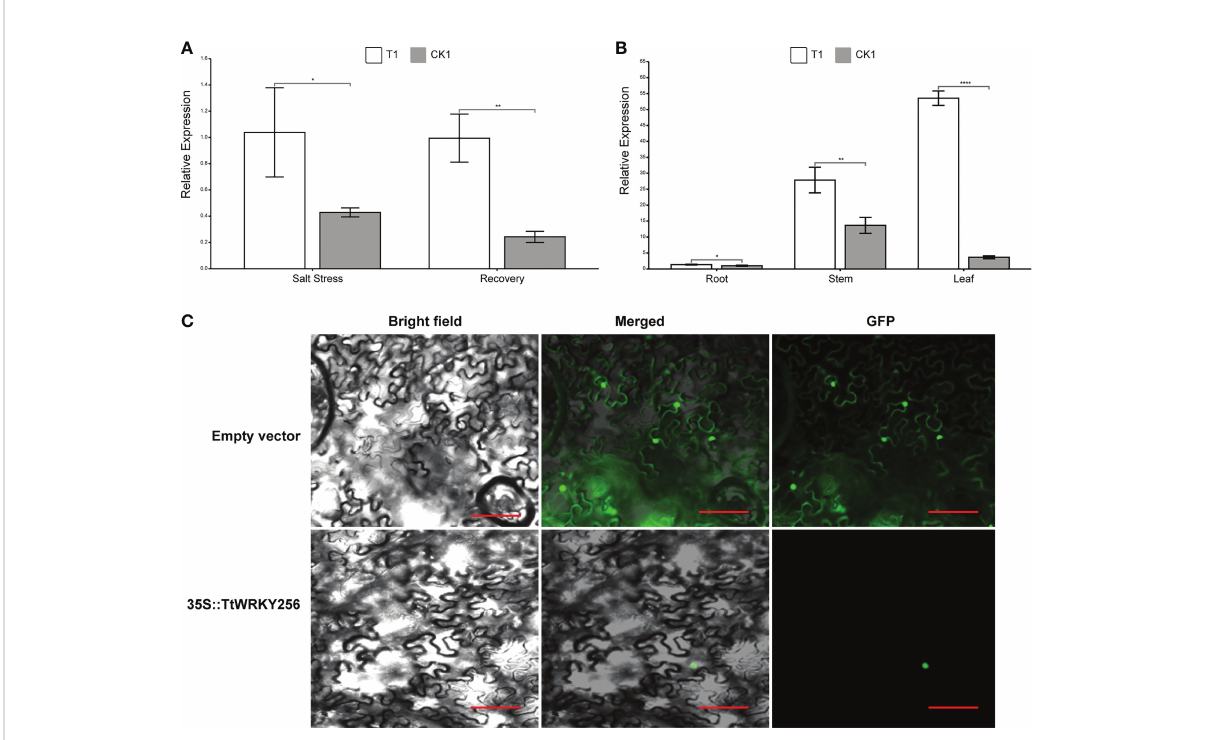
FIGURE 9 Expression and Subcellular localization of TtWRKY256. (A) Relative expression levels of TtWRKY256 in roots under salt stress and recovery conditions; (B) Relative expression levels of TtWRKY256 in roots, stems, and leaves under salt stress; (C) Subcellular localization of the TtWRKY256 protein in tobacco protoplasts, Scale bar = 20 mm. Asterisk, double and triple asterisks indicate signi fi cant differences (p < 0.05, 0.01 and 0.001, respectively) between